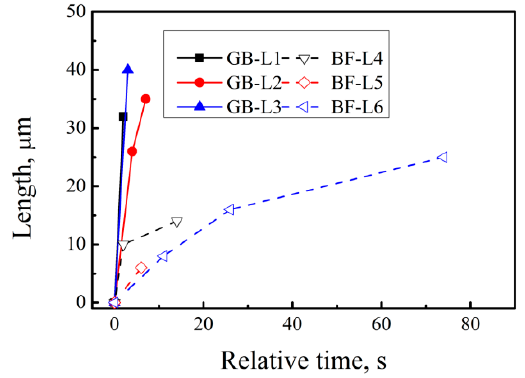
Figure 3. Grow rate of bainitic ferrite plates in the longitudinal direction at different nucleation locations.